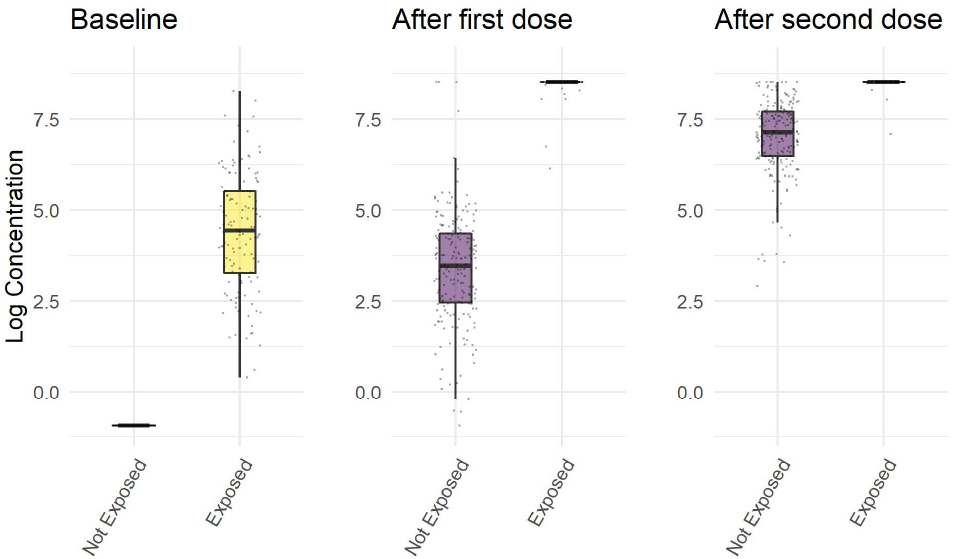
Figure 1. Logarithmic concentration of anti RBD antibodies against SARS-CoV-2 ′ s spike protein (including IgGs) before vaccination with BNT162b2, 21 days after the first dose of BNT162b2, 12 days after the second dose of BNT162b2 in symptomatic and asymptomatic subjects.